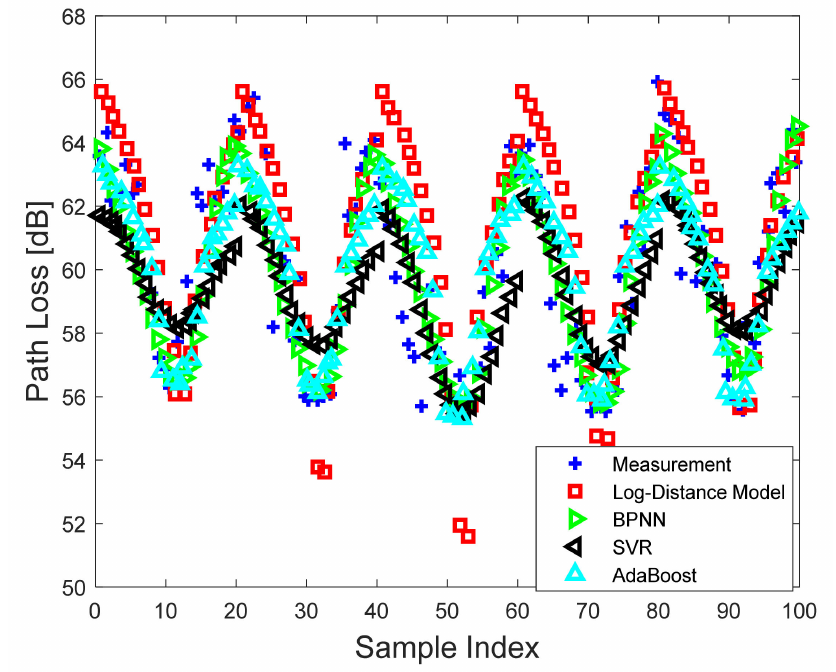
Figure 5. Path loss prediction performance of machine learning algorithms using 100 sample data for OSRC base station operating at 96.5 MHz. Note: For sample data of OSRC, only 30 computed samples were used in the training.